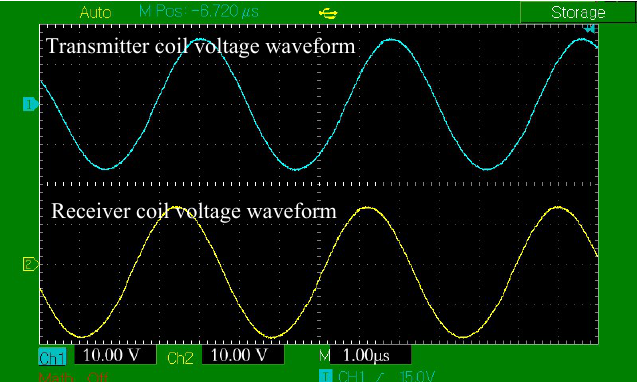
Figure 14. The experimental waveforms of case 1 under strongly coupled state.